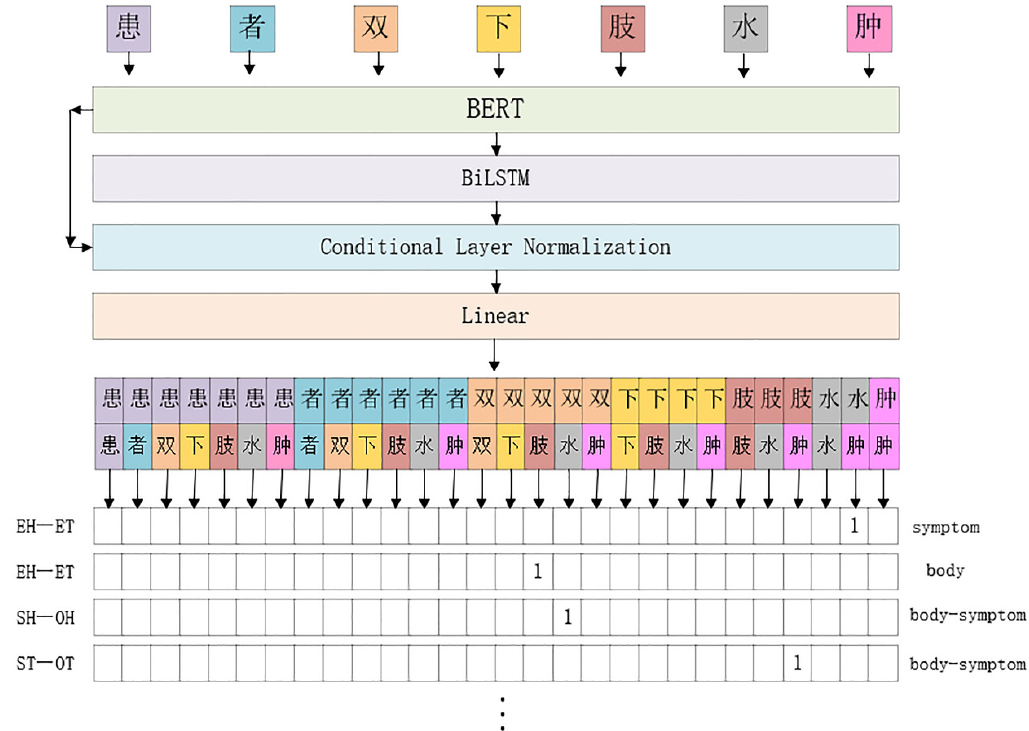
Figure 1. The model structure. In this example, the input sentence is ‘ 患者双下肢水肿 ’ (The patient had edema of both lower limbs), and we use a different color for each word.